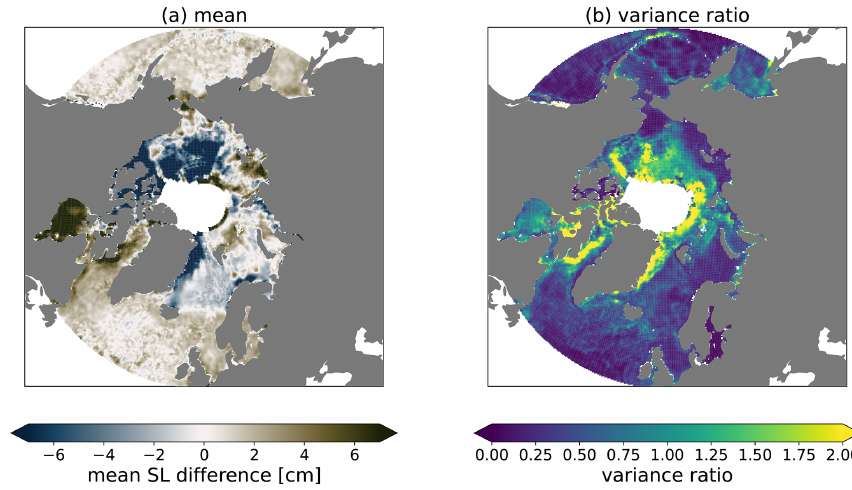
Figure 8. Differences between arctic product and CMEMS global products: (a) mean difference and (b) variance of the differences expressed as a fraction of signal